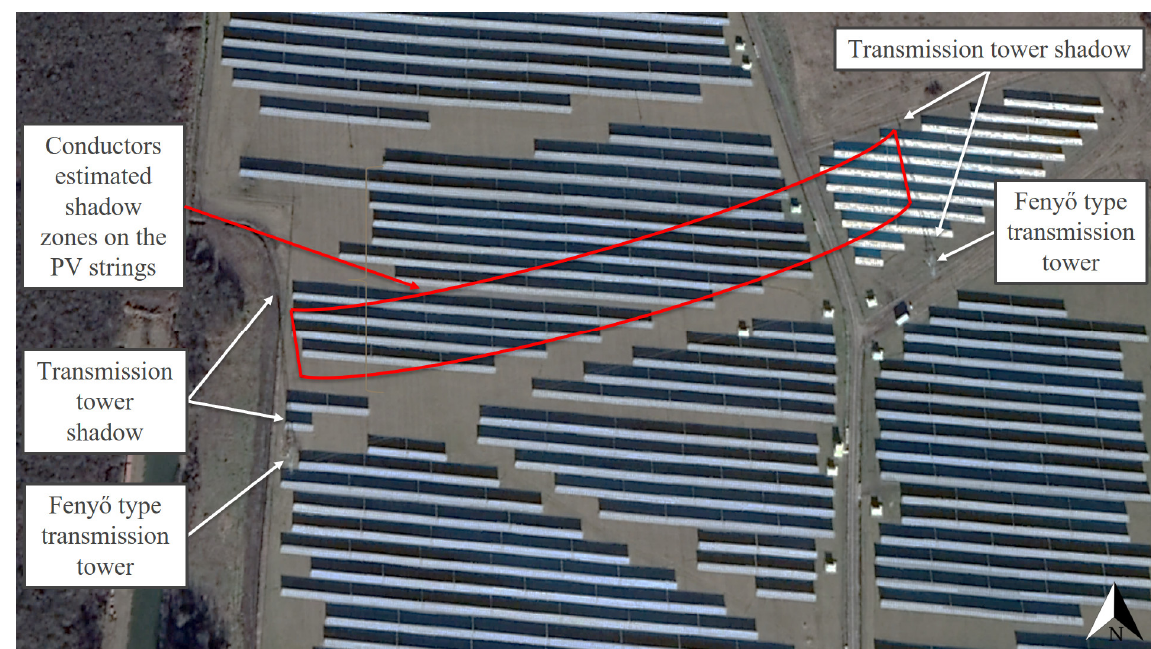
Figure 3. The shading effects of Fenyő-type transmission towers and their conductors on 2 January 2020 at approximately 11:30 a.m. (local time) in Táplánszentkereszt, based on [41].